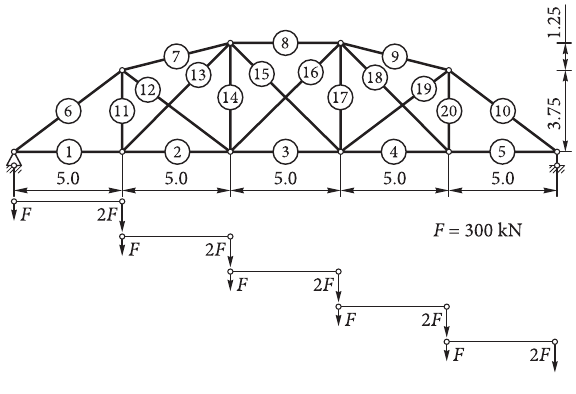
Fig. 3. Truss subjected to moving